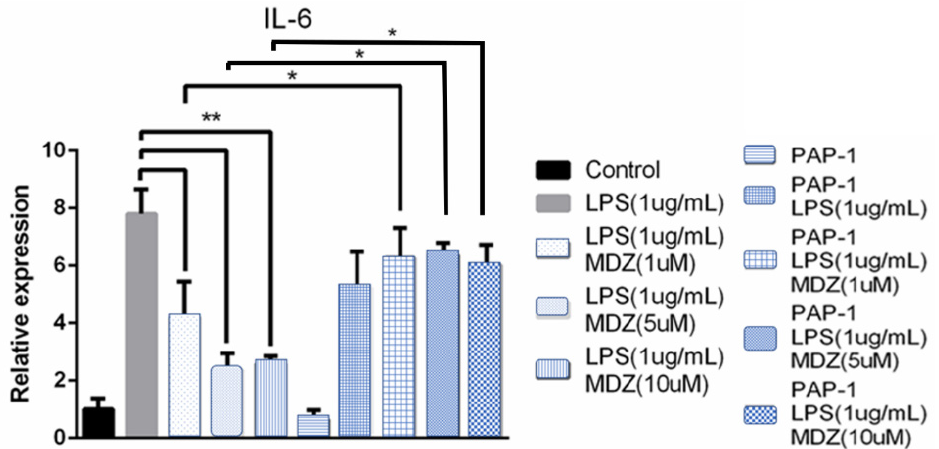
Figure 9. Effect of PAP-1(Kv1.3 channel blocker) on cytokine (IL-6) expression on MDZ (1, 5 and 10 µ M) treated Jurkat T-lymphocytes. n = 3, data were mean +/- SEM, PAP-1 + LPS + MDZ (1,